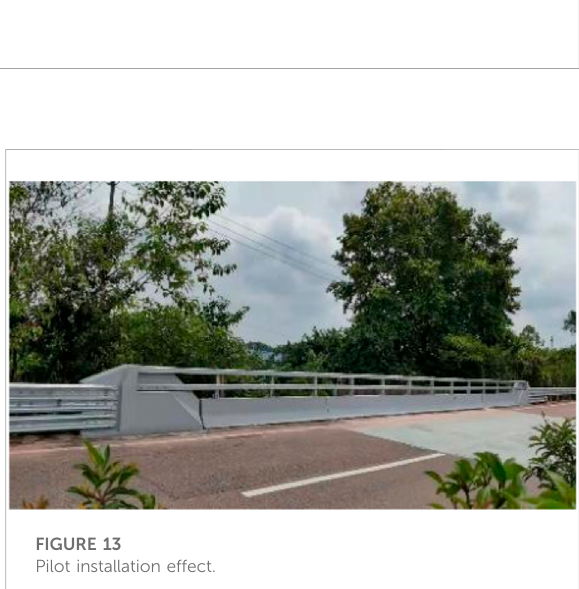
FIGURE 13 Pilot installation